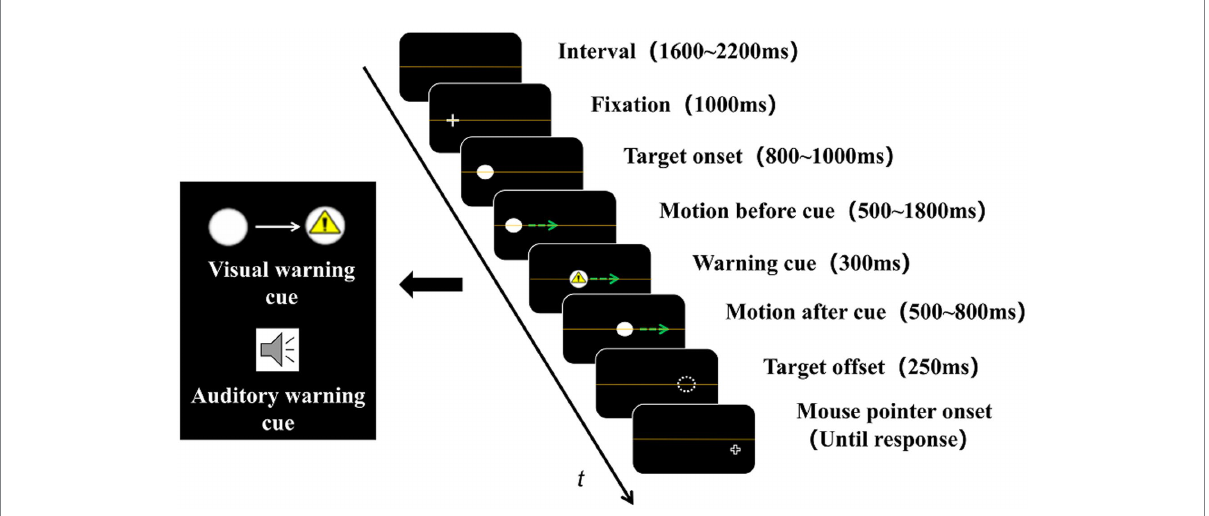
FIGURE 1 Experimental sequence. The green arrow in the picture indicates the direction of the target ball’s motion (absent during the experiment). The warning cue was presented during target motion. The visual cue was a triangle warning sign (above the black box on the left), whereas the auditory cue was a pure tone (below the black box on the left). In a cue-absent trial, neither the visual nor the auditory cue was